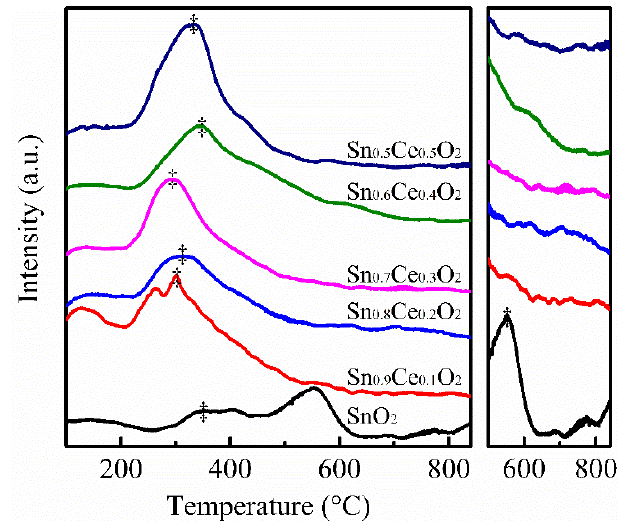
Figure 8. O 2 -TPD profiles of the SnO 2 and Sn x Ce 1-x O 2 fiber catalysts.